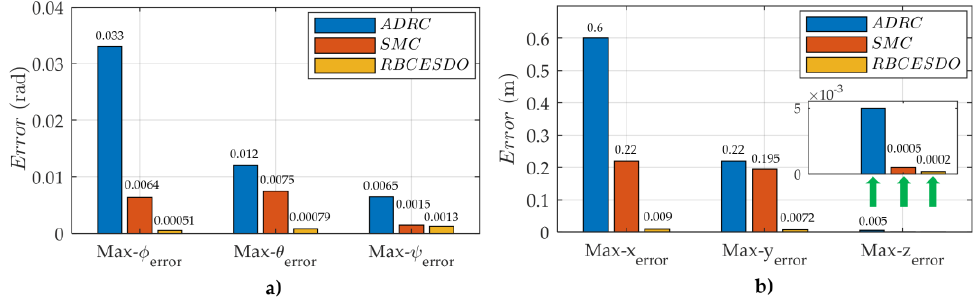
Figure 9. Comparison of maximum attitude tracking error ( a ) and maximum position tracking error ( b ) of the proposed RBCESDO, SMC, and ADRC.